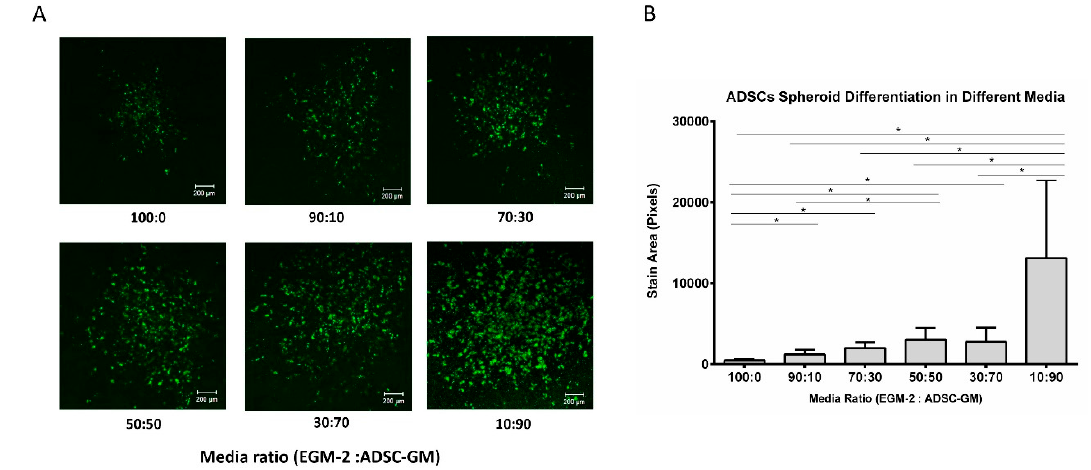
Figure 3. EGM-2 inhibits ADSC spheroid differentiation. ( A ) BODIPY staining of ADSC spheroids in varying media ratios and ( B ) quantitative analysis of BODIPY staining. Values are means ± SD, n = 4. One-way ANOVA followed by Tukey’s multiple comparisons test was performed. * Denotes significant difference ( p < 0.05) between groups.